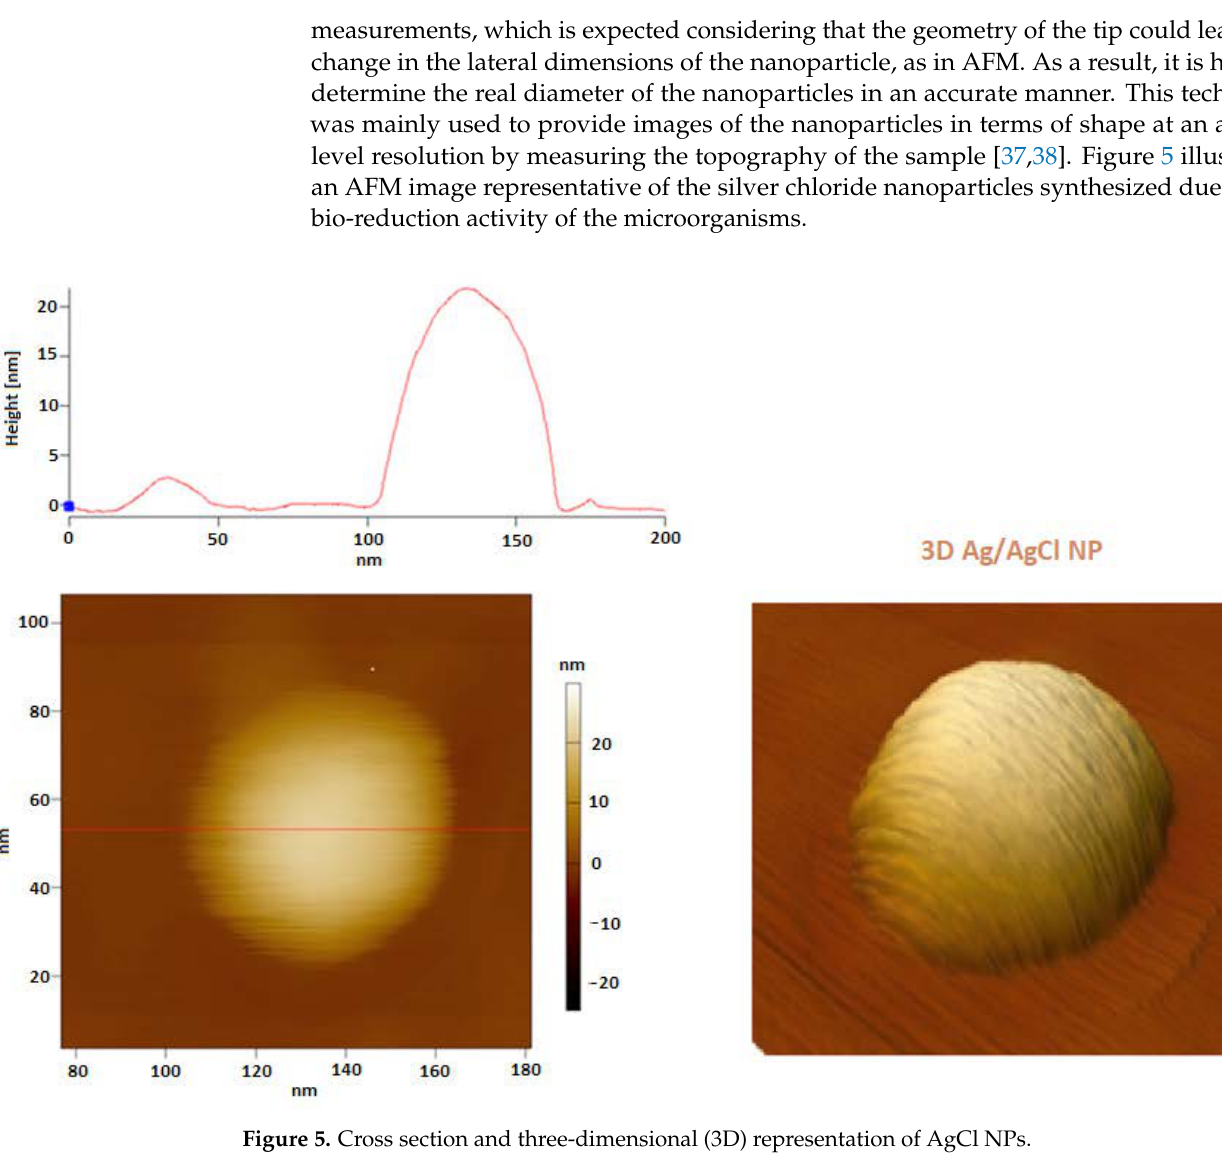
Figure 5. Cross section and three-dimensional (3D) representation of AgCl